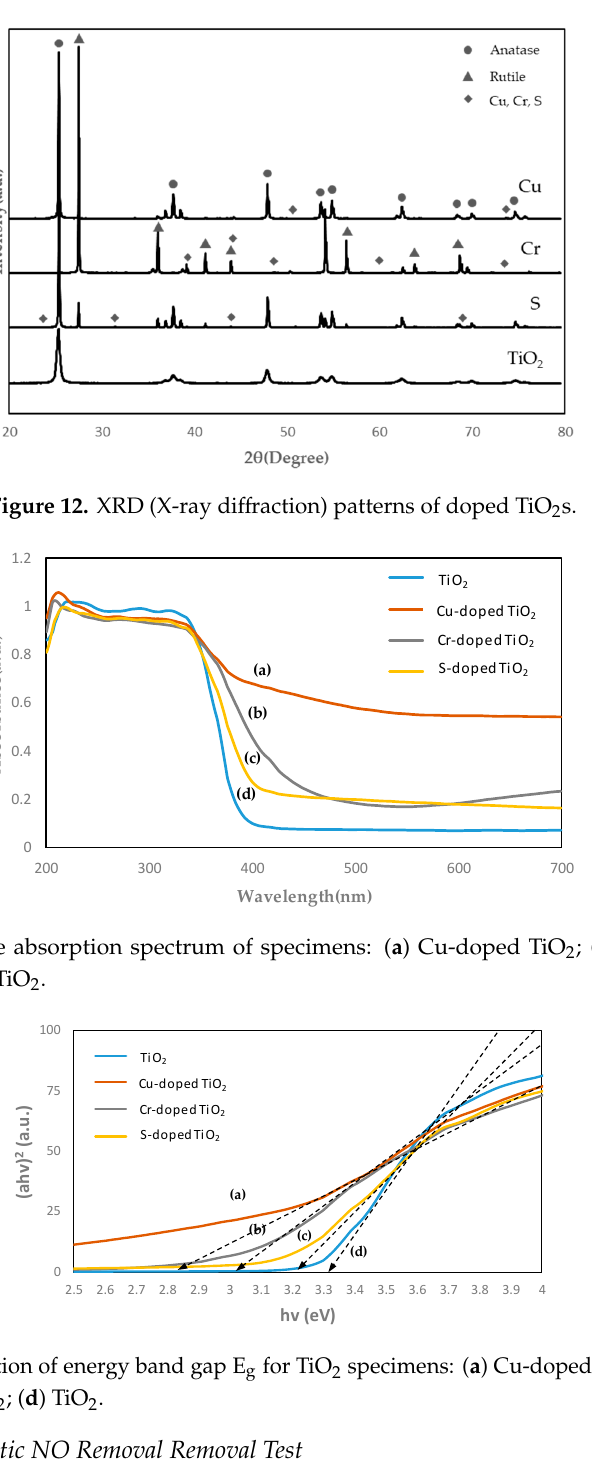
Figure 14. Determination of energy band gap E g for TiO 2 specimens: ( a ) Cu-doped TiO 2 ; ( b ) Cr-doped TiO 2 ; ( c ) S-doped TiO 2 ; ( d ) TiO 2 .